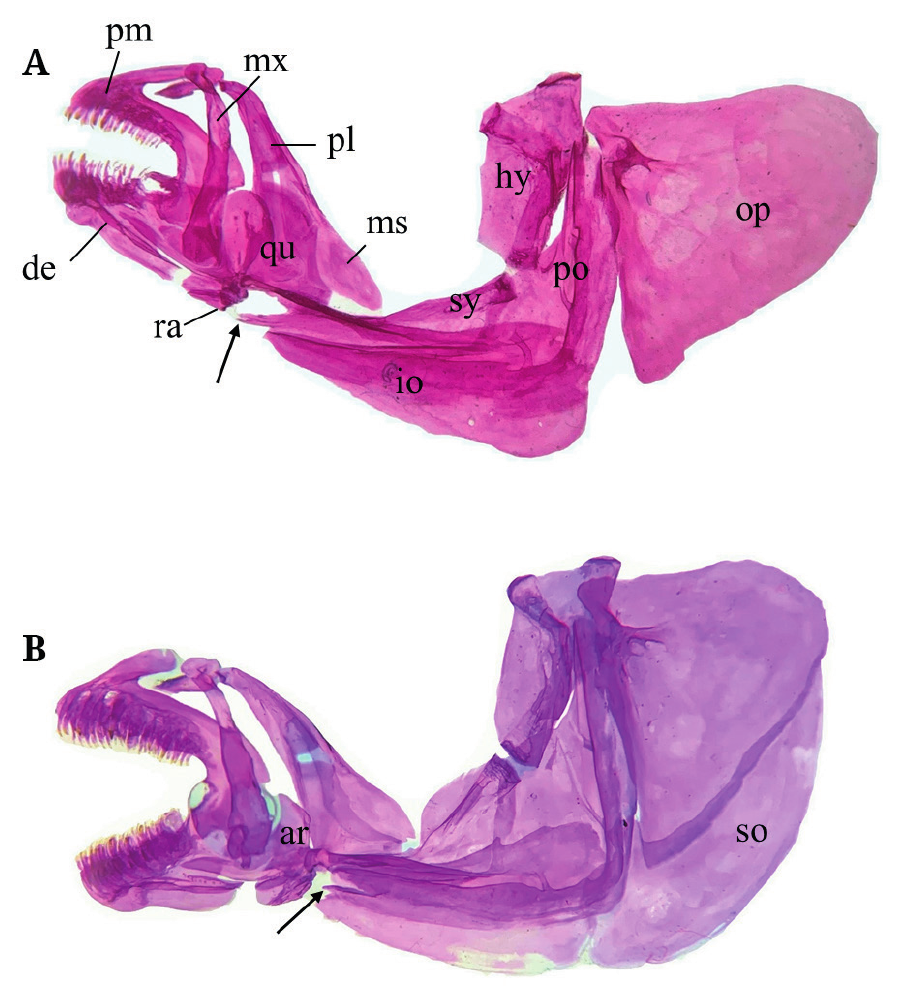
FIGURE 3 | Lateral view of left jaws, suspensorium and opercular series in specimens cleared and stained. A. Tlaloc portillorum (MZ-UNICACH 7222, 70.5 mm SL); B. Profundulus mixtlanensis (MZ-UNICACH 6716, 55.6 mm SL). Arrow points to dorsal margin of the interoperculum, with a long or short extension. Abbreviations: de, dentary; pm, premaxilla; ra, retroarticular; mx, maxilla; pl, palatine; qu, quadrate; ar, articular; ms, mesopterygoid; io, interopercle; sy, sympletic; hy, hyomandibula; po, preopercle; op, opercle; so, subopercle.